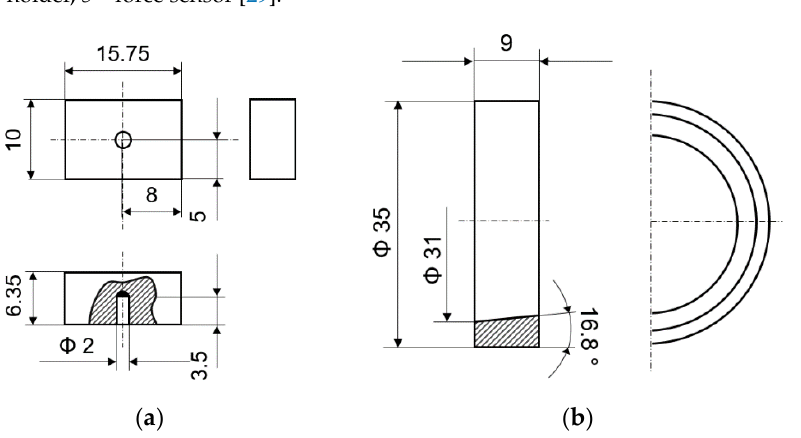
Figure 2. The dimensions of: ( a ) specimen; ( b ) counter-specimen [29] (Unit: mm) .